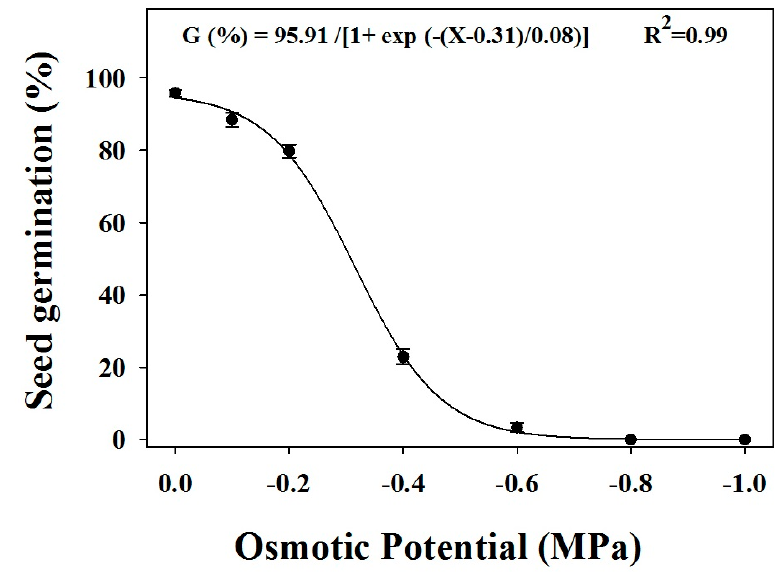
Figure 4. The effect of different osmotic potentials on the seed germination of three biotypes of Brachiaria eruciformis . Each point of the graph represents a mean value of the germination data (pooled across biotypes). A three-parameter sigmoid model was fitted to germination (%). The vertical bars represented the standard error of mean.